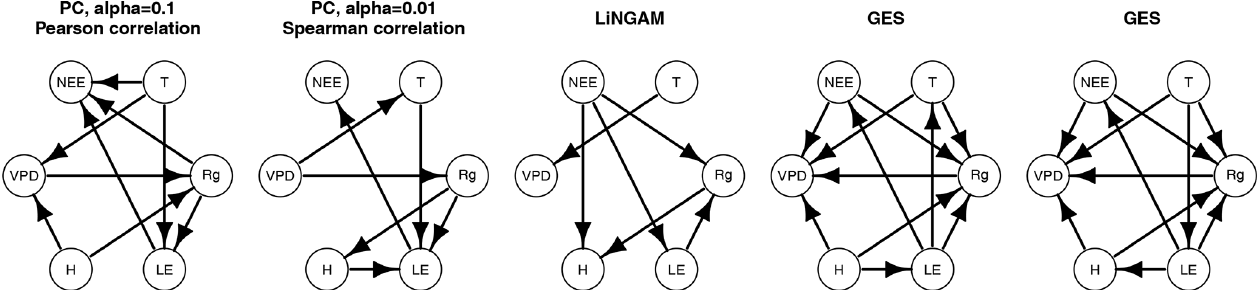
Figure 1. Different algorithms produce different causal graphs for the same data. The PC algorithm is started from a full graph, LiNGAM has no defined initial graph and we started GES from an empty graph. GES produces (multiple) graphs with indistinguishable conditional dependency relationships.